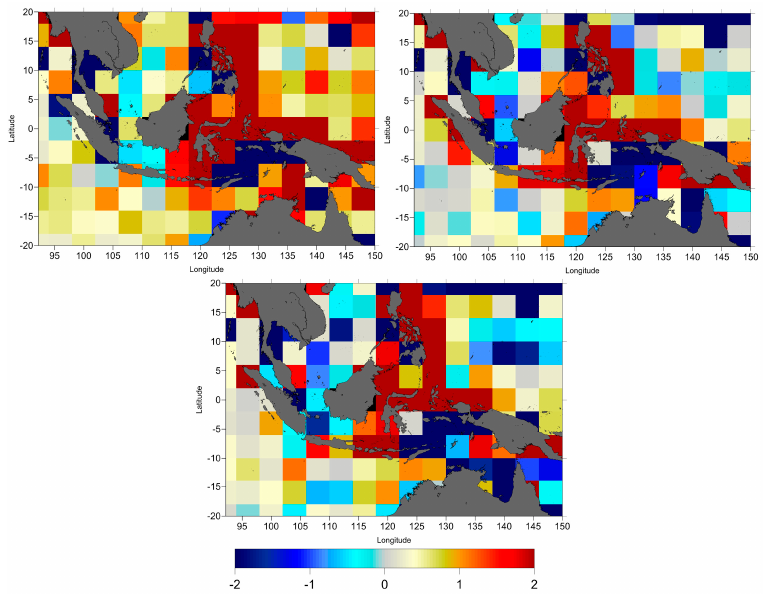
Figure 18. Along-track SLA variance differences (cm 2 ), between DTU13 and CNESCLS2011 MSS models for TOPEX/Poseidon cycles 1 to 364, Jason-1 cycles 1 to 259 and Jason-2 cycles 1 to 280 .